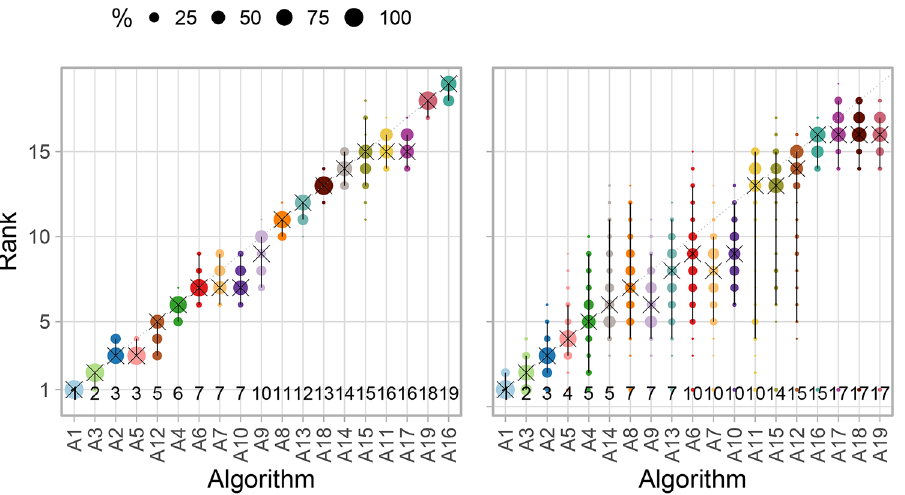
Figure 13. Blob plots for selected tasks of the MSD visualize bootstrap results. T 1 / T 2 : task with stable/unstable ranking. Ranks above algorithm names highlight the presence of